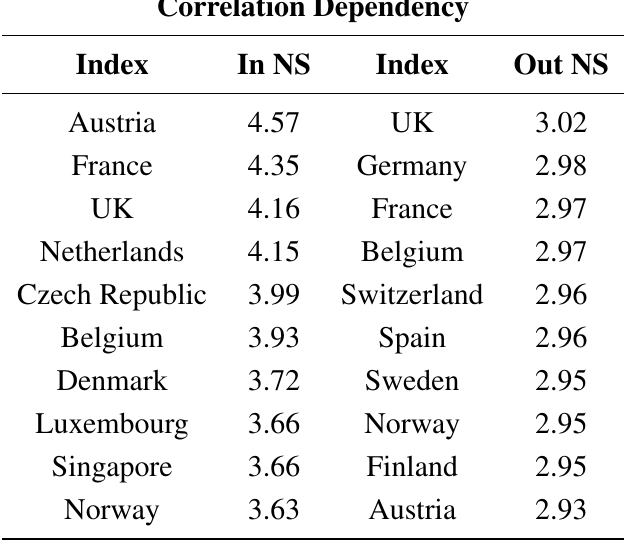
Table 1. Top ten indices according to In and Out Node Strengths based on correlation dependency.